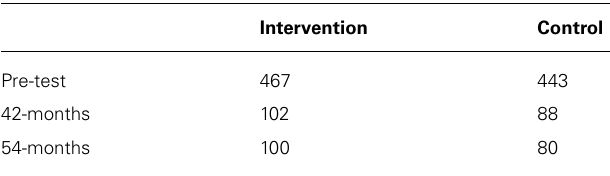
Table 2 |Total number of participants in intervention and control groups at pre-test, 42-month, and 54-month follow-up. Intervention